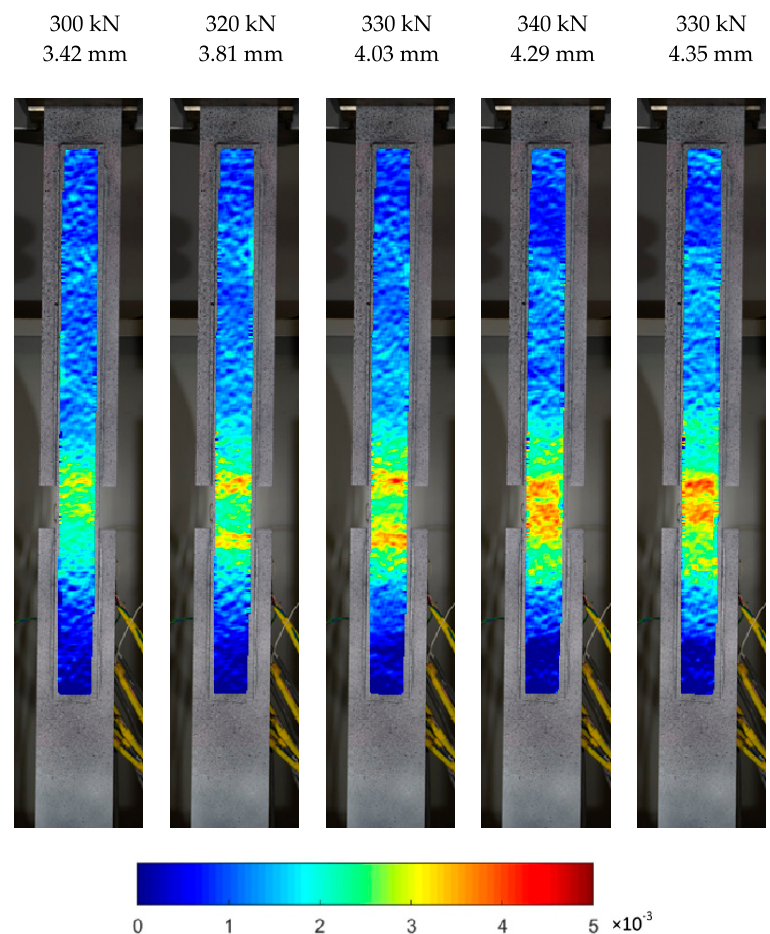
Figure 10. Longitudinal strain distribution maps at failure in S/DL/MA/RS-200-4/P2 specimen.